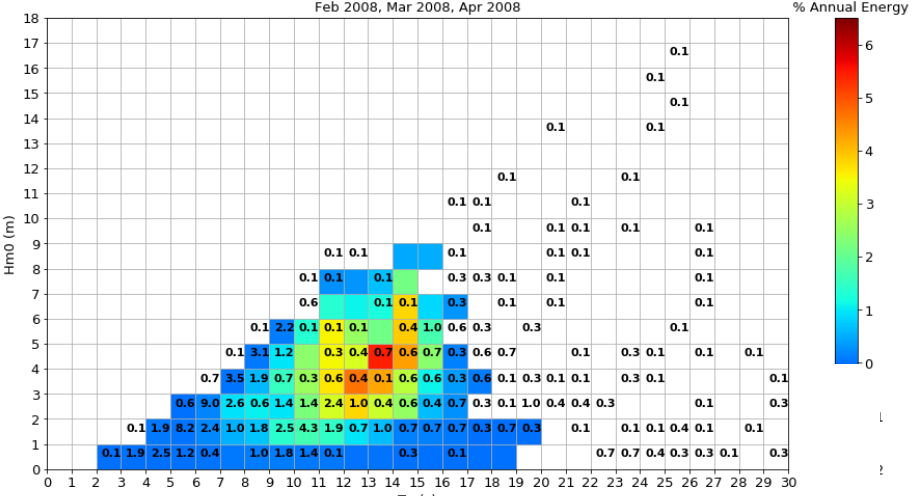
Fig 4. Scaled up Burghead ( H m0 , T p ) % occurrence scatter table (tabulated numbers) for Feb-Apr 2008 overlaid on Billia Croo ( H m0 , T p ) % annual incident energy scatter colour map for